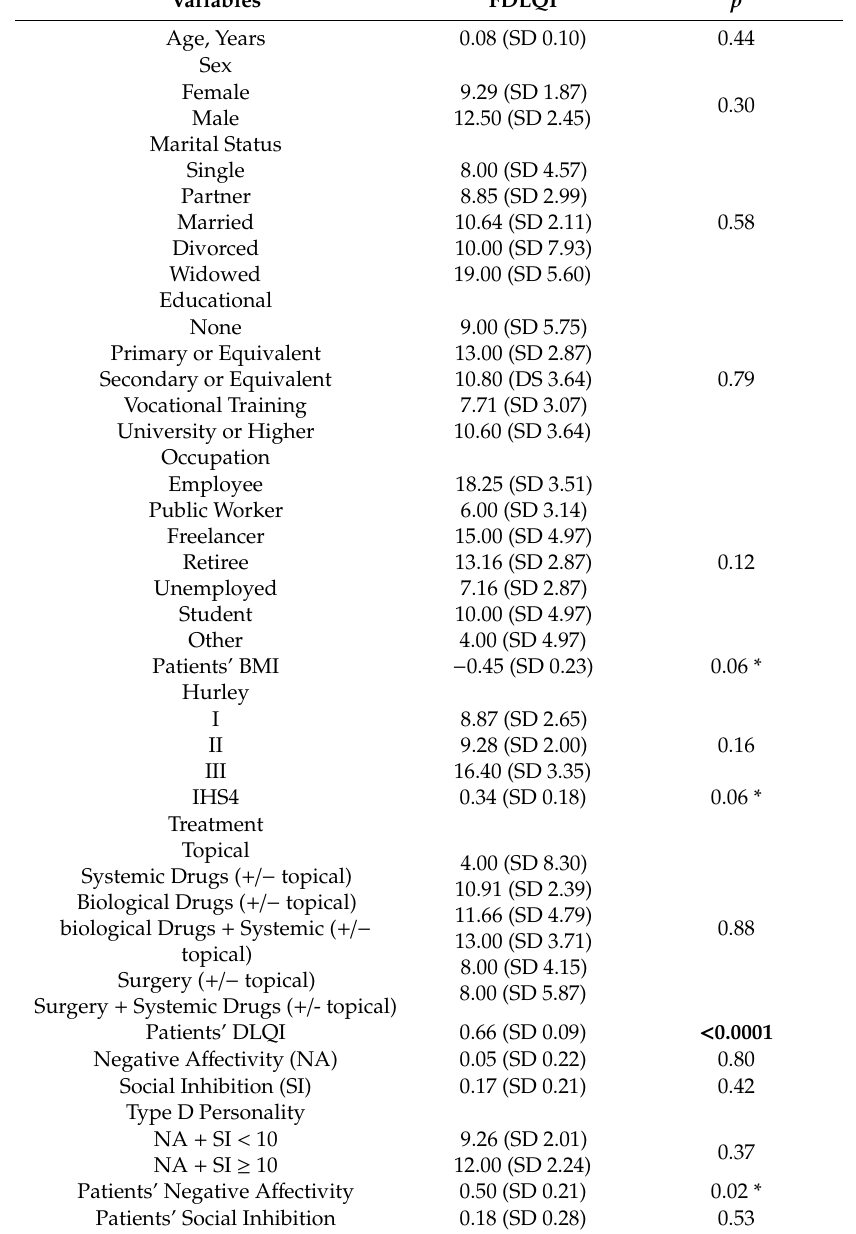
Table 3. Univariate analysis of potentially factors associated with quality of life in